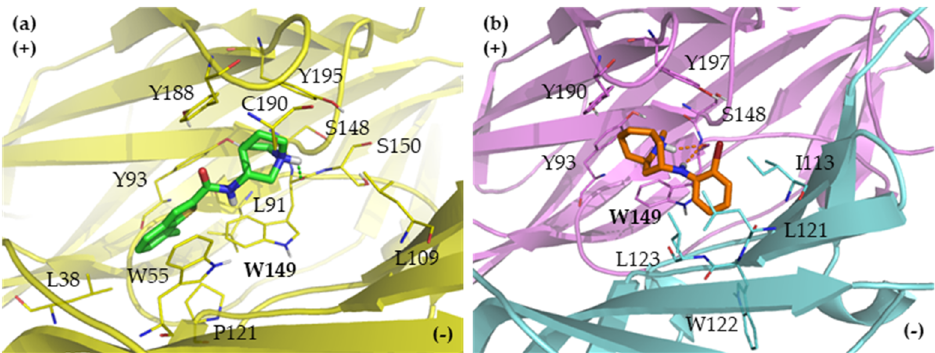
Figure 3. The docked poses of ( a ) EVP-6124 (green), an α7-selective nAChR ligand in the human α7 nAChR homology model (yellow) and ( b ) AT-1001 (orange), an α3β4-selective nAChR ligand in the human α3β4 nAChR homology model (pink and cyan). The bold letters show amino acids forming hydrogen bond interactions. red, oxygen; blue, nitrogen.